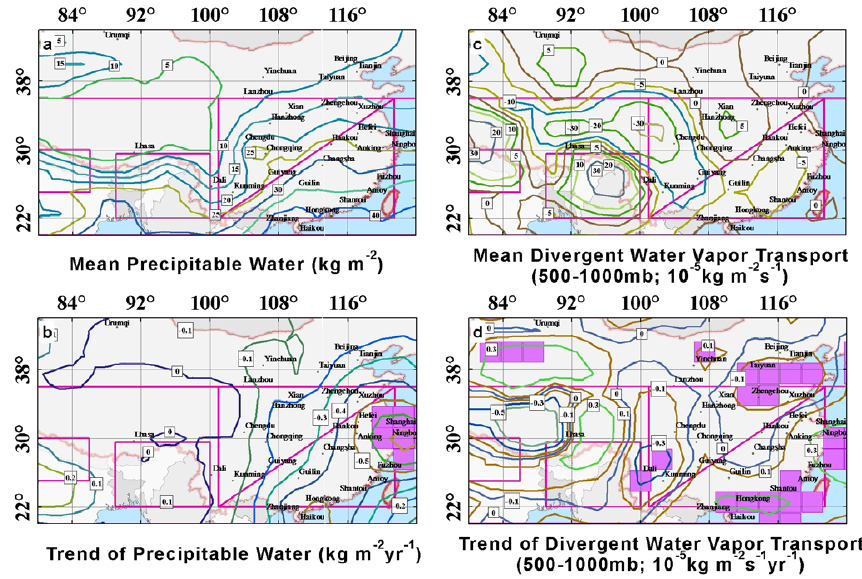
Figure 8 . Spatial distributions of column precipitable water (PW) and divergence of water vapor transport (DWVT), and their corresponding trends in spring during 1998-2009. The shaded grids are the trend with significant level above 95%.